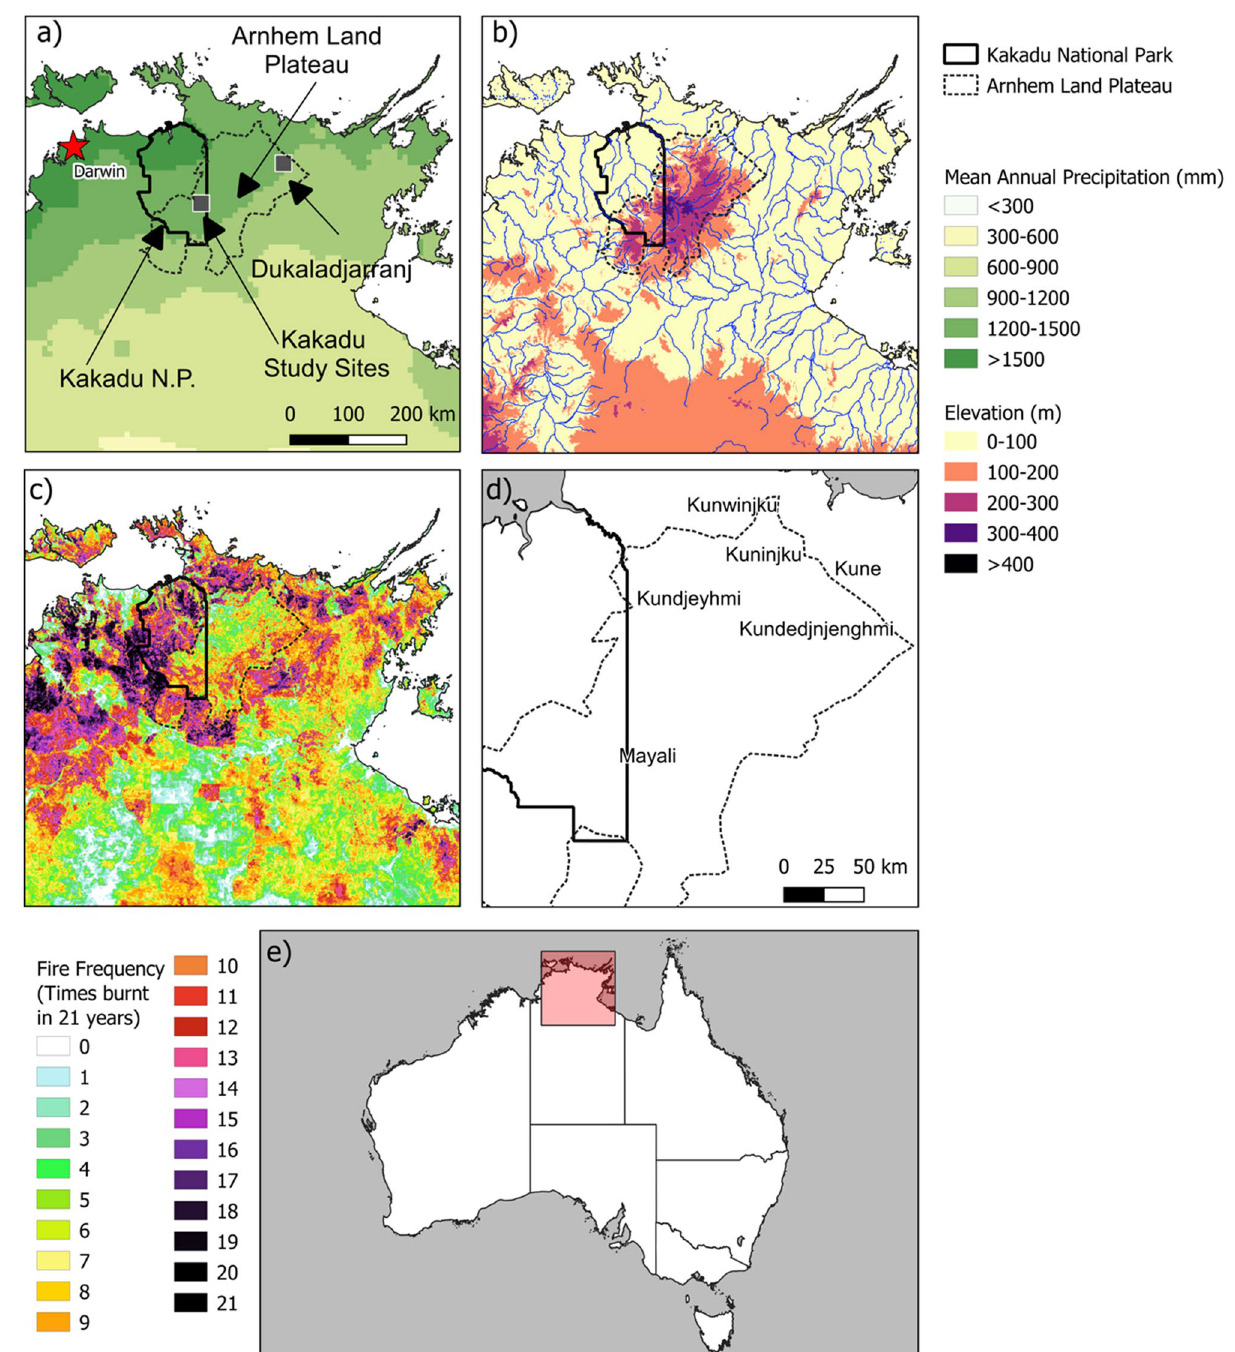
Arnhem Plateau 31 . ( e ) Australian continental geographic context of the study region. The boundaries of Kakadu National Park and the boundary of the Arnhem Plateau (defined by outcropping sandstone 80 are indicated in panels ( a – d